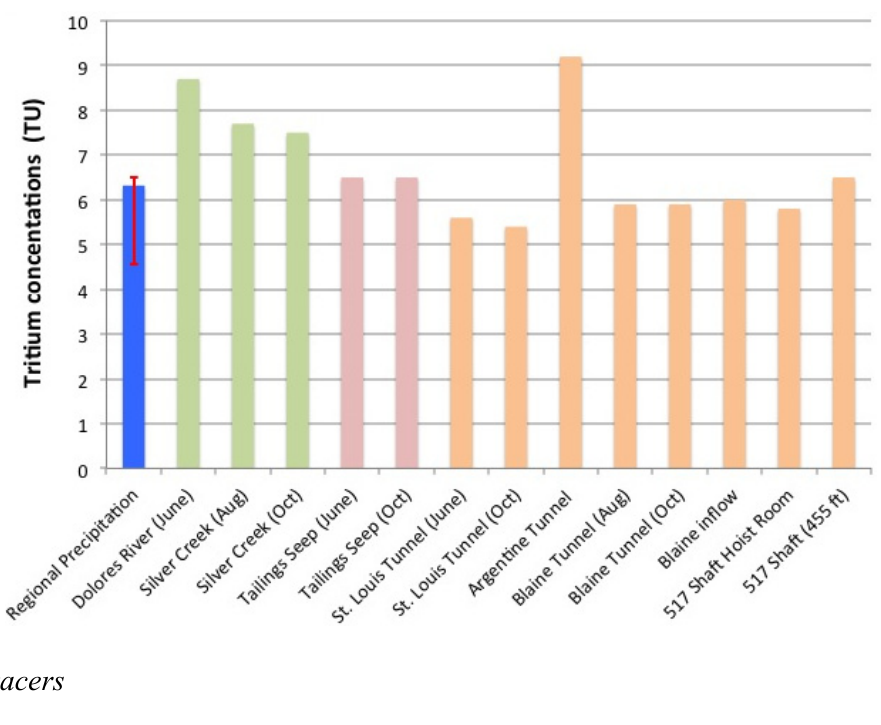
Figure 6. Tritium ( 3 H) values from recent (2010–2011) regional precipitation (blue), surface waters (green and pink), and mine waters (orange). The blue precipitation bar represents the mean value of all samples while the red error bar represents the 25th and 75th